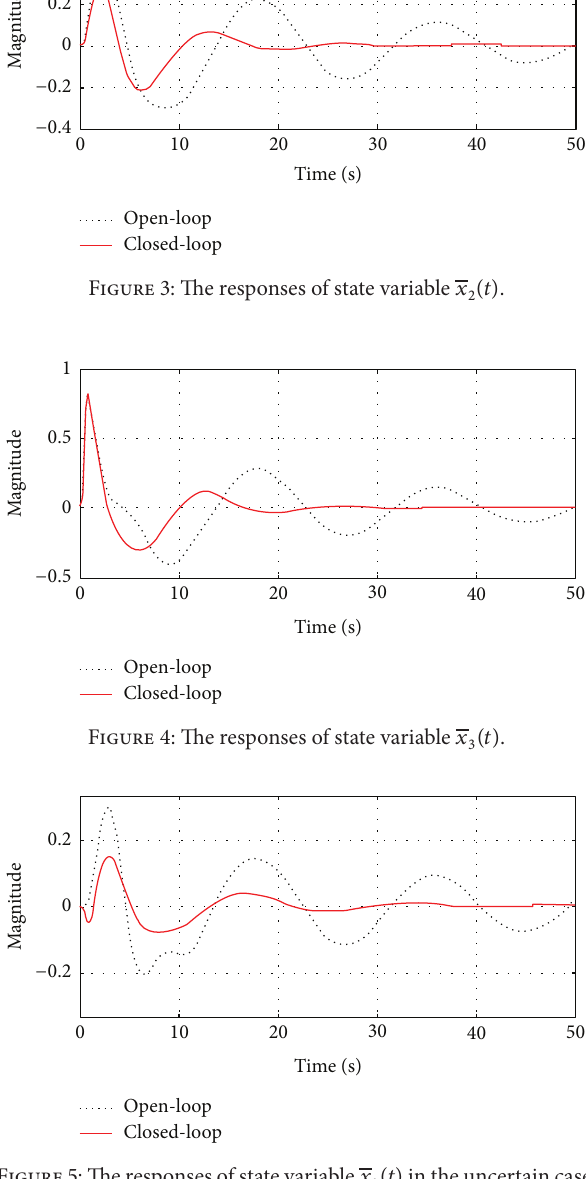
Figure 5: The responses of state variable 𝑥 1 (𝑡) in the uncertain